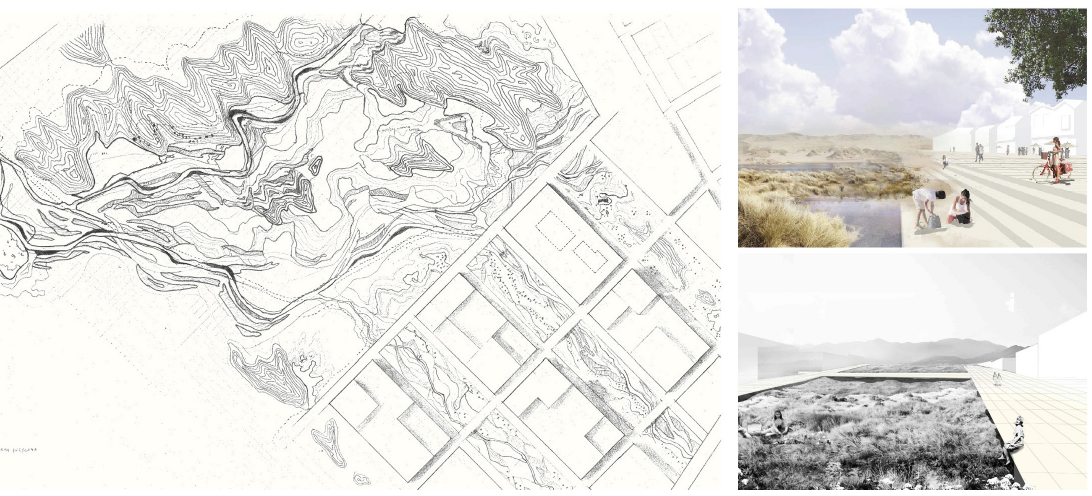
Figure 4. Shifting Downtown , a speculative design by Winston Dewhirst. Plan of existing street grid converted to wide wetlands and dunes, linked to existing wetland and dune (left); a porous urban edge to wetland dune system (top right); compact town centre development allows streets to be converted to wetlands and dunes. Source: Winston Dewhirst .